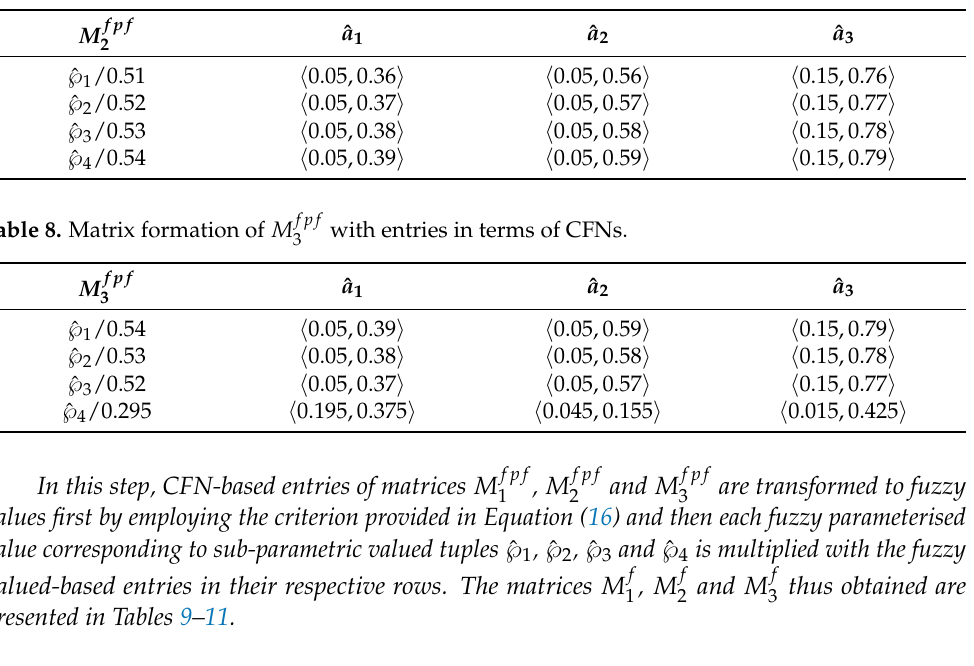
Table 7. Matrix formation of M fpf